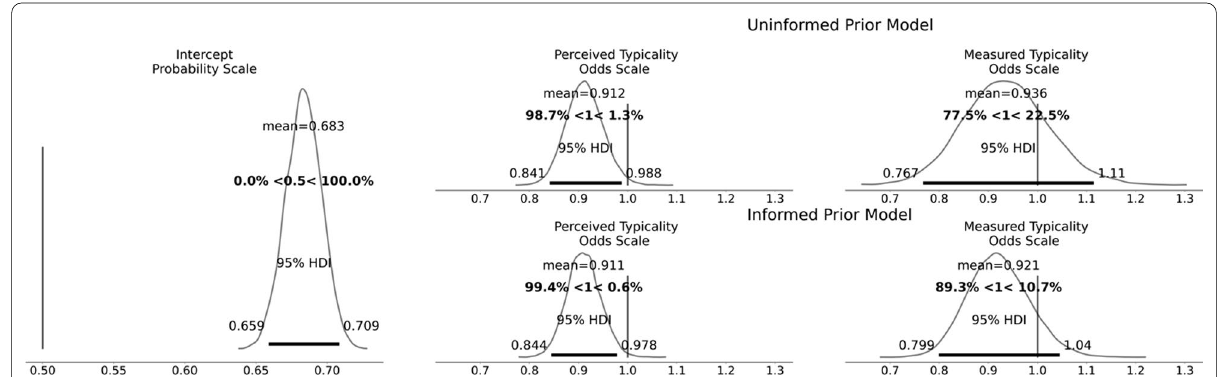
Fig. 4 Posterior distribution of coefficients when manipulating the lower face, from models with both informed and uninformed priors. Note the intercept posterior is identical in both